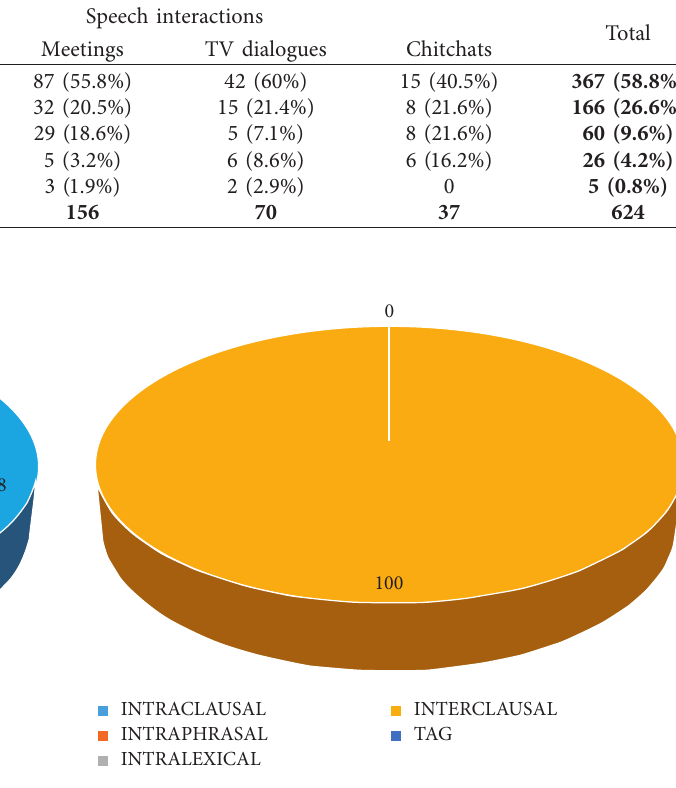
Figure 3: Types of code-switching in